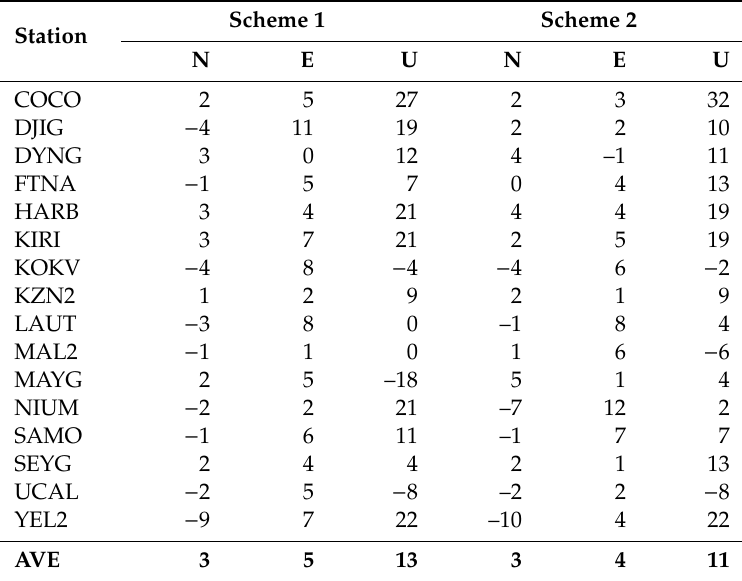
Table 3. Biases of PPP for each station (unit: